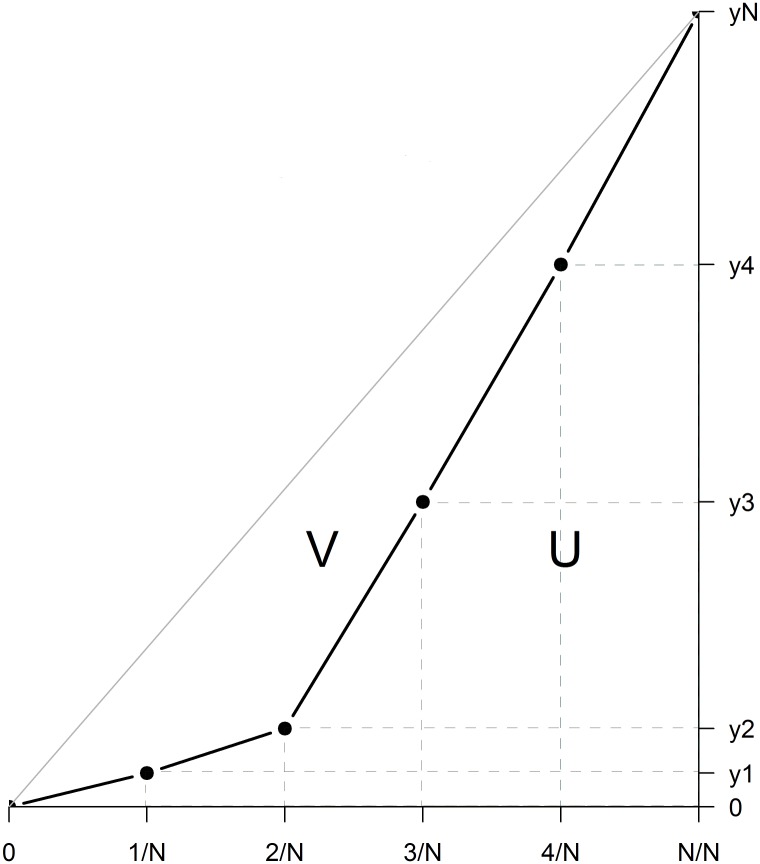
Illustration of how Protection Equality is calculated (here N = 5).The line of perfect equality is shown in grey. The black curve is equivalent to the Lorenz curve and formed by the cumulative level of protection of each ecoregion i against i/N, with 1 ≤ i ≤ N. On the y-axis, y1 to yN are either cumulative fixed area protection (pi) or cumulative proportional protection (pi /ai). The dashed lines highlight the triangles and rectangles used to approximate area U, with PE calculated as the ratio of U over U+V.